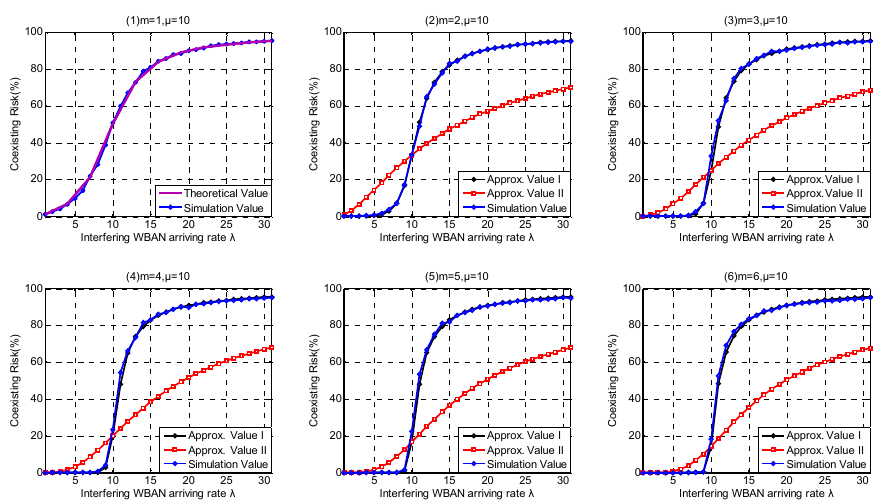
Figure 15. Coexisting Risk in Service-dependent coexisting WBANs.